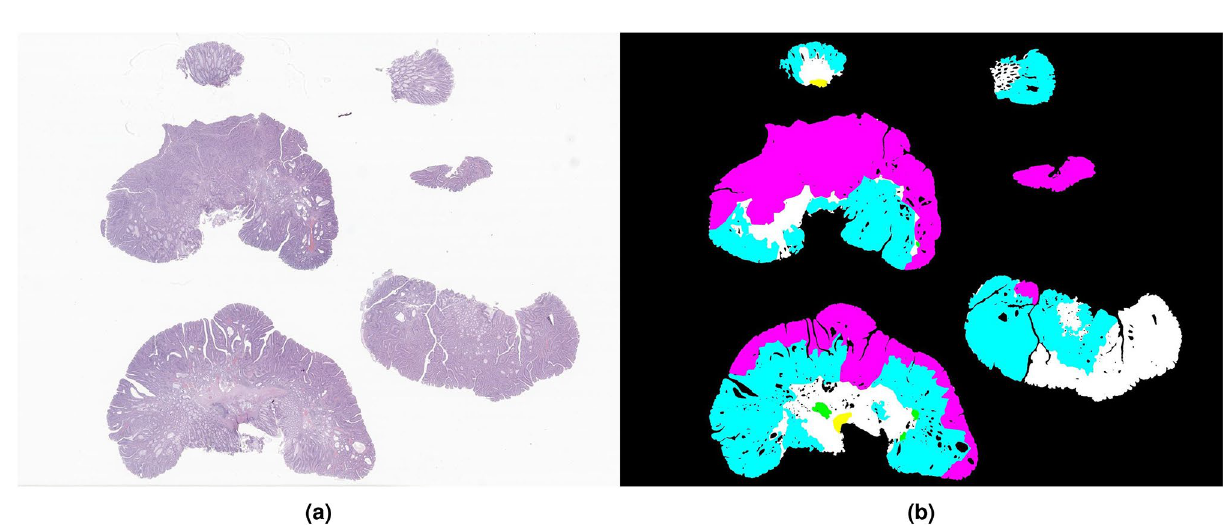
Figure 3. Example of a whole-slide ( a ) from the CRC dataset. Manual segmentations ( b ) include regions annotated as non-neoplastic (white), low-grade lesions (blue), high-grade lesions (pink), linfocytes (green) and fulguration